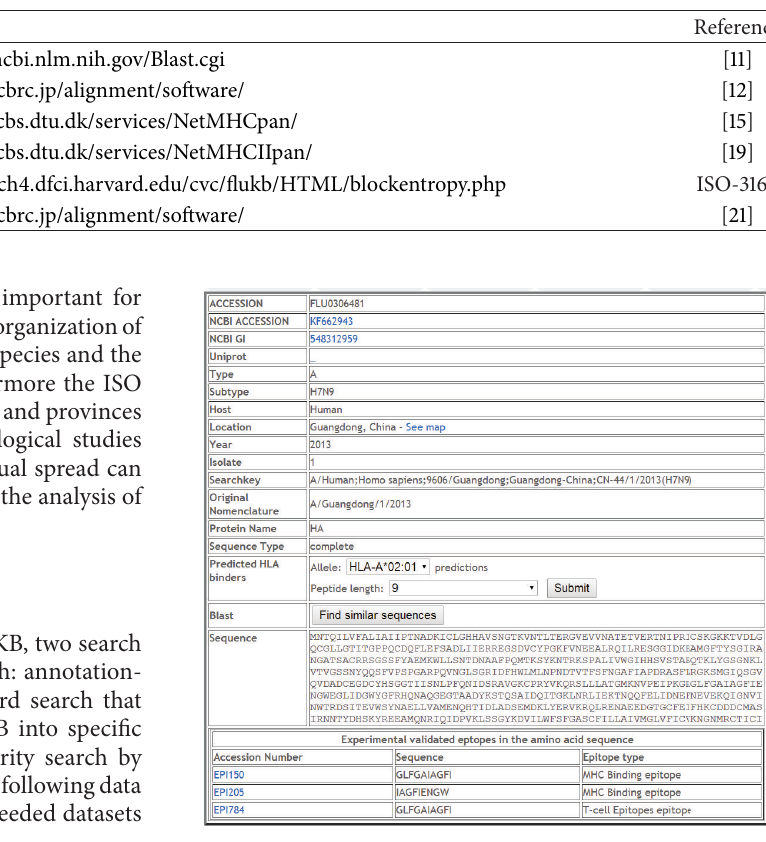
Table 4: The sources of the integrated tools in FluKB and URL for their stand-alone versions web services.